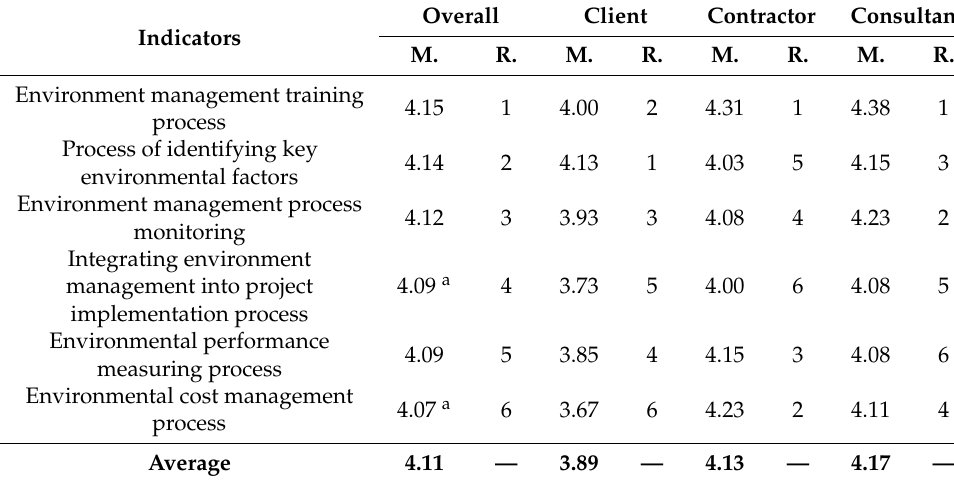
Table 2. Environment management